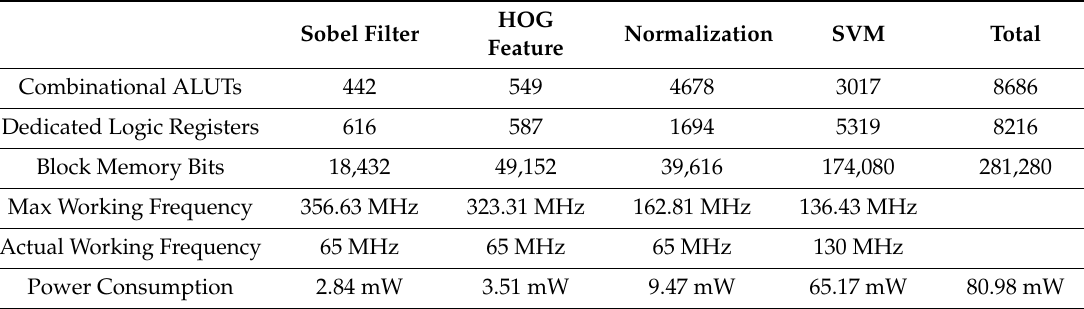
Table 1. Hardware resources of each module *.